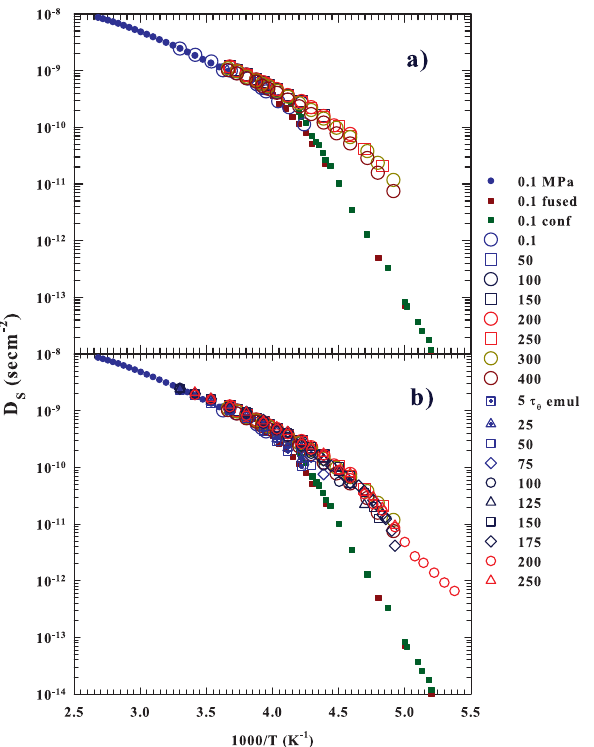
Figure 3. ( a ). The isobars of the bulk water self-diffusion data, measured by an NMR experiment, in the pressure range 0.1–400 MPa, are illustrated in an Arrhenius plot [20]. ( b ) The ( a ) data integrated with those corresponding to the reorientational relaxation times τ θ evaluated in terms of NMR theories from the spin-lattice relaxation times T 1 and measured in the emulsion’s water (range 0.1–250 MPa) [22].